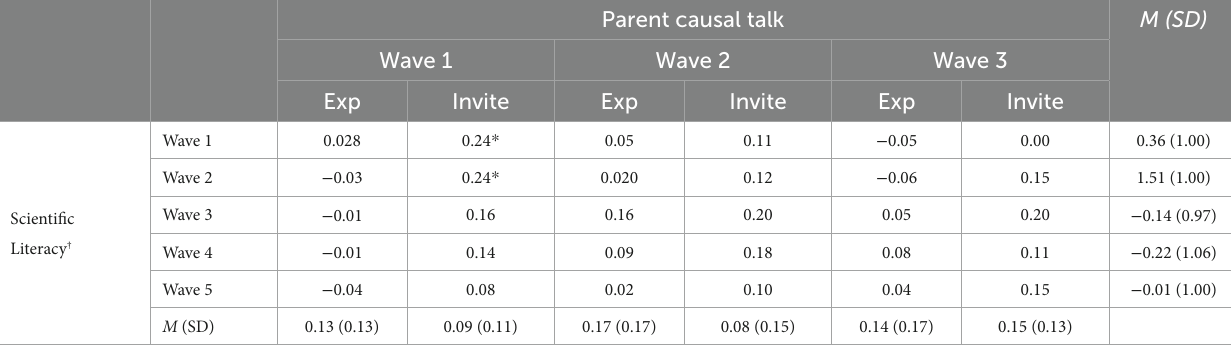
TABLE 6 Bivariate correlations for parent talk and scientific literacy.